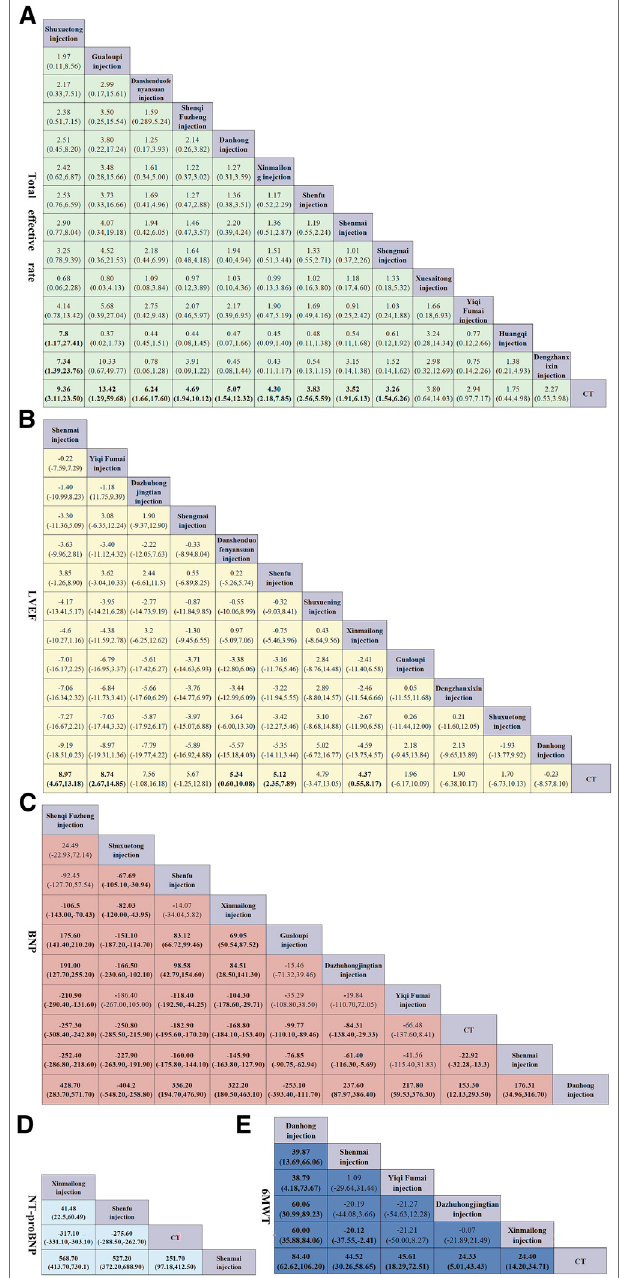
FIGURE 4 | Pooled estimates of the network meta-analysis. (A) Pooled odd ratios (95% credible intervals) for the total effective rate. (B) Pooled odd ratios (95% credible intervals) for LVEF. (C) Pooled odd ratios (95% credible intervals) for NT-proBNP. (D) Pooled odd ratios (95% credible intervals) forBNP. (E) Pooledoddratios(95%credibleintervals)for6MWT.Dataineach cell are hazard or odds ratios (95% credible intervals) for the comparison of row-de fi ning treatment versus column-de fi ning treatment. Signi fi cant results are in bold. All the TCMIs based on CT.